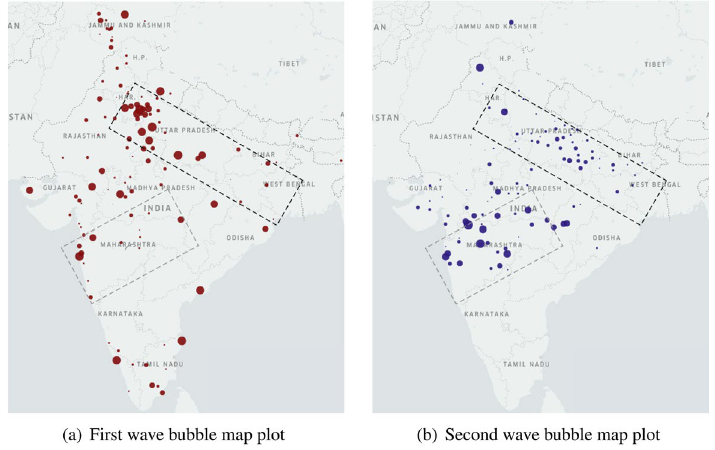
Figure 3. Bubble map plots of κ ⋆ for Indian districts that have κ ⋆ > 0 for the first wave in ( a ) and the second wave in ( b ). The size of the bubble indicates the magnitude of κ ⋆ . The dotted areas identify Maharashtra and the Ganges belt.